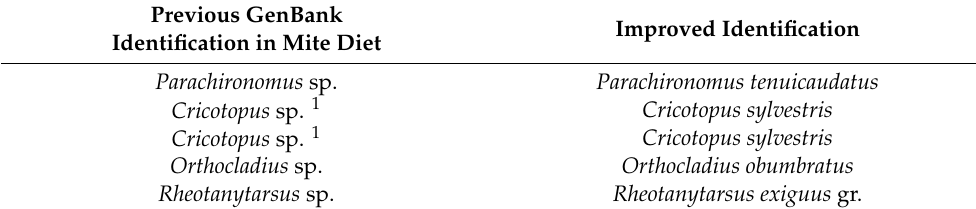
Table 2. Summary of genus to species Improvements.